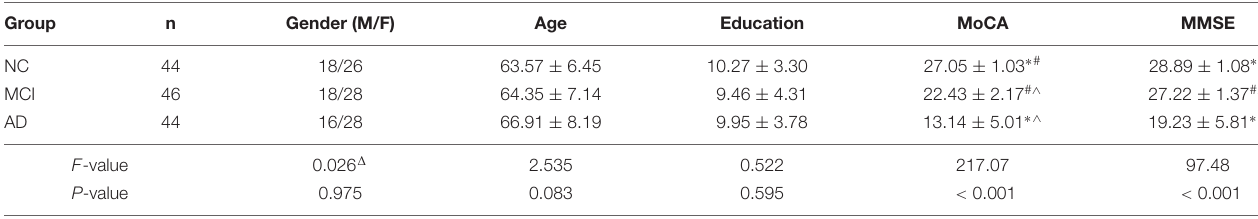
TABLE 1 | Subjects characteristics (mean ± SD).